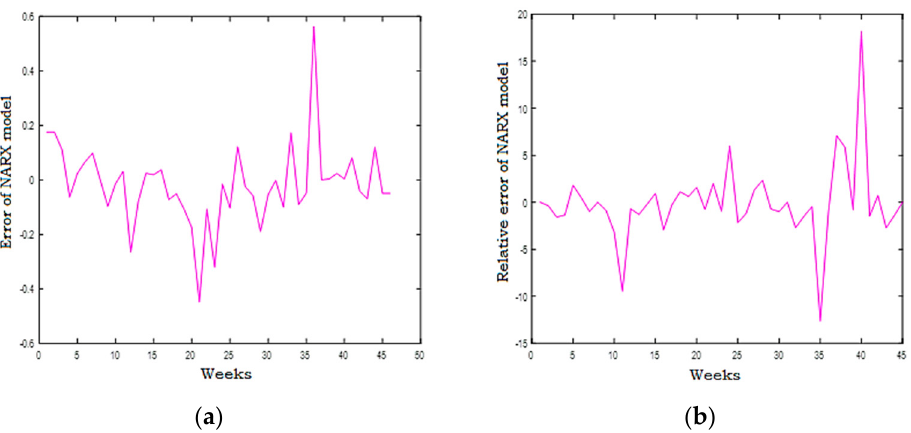
Figure 31. Prediction of solar radiation using the NARX model.